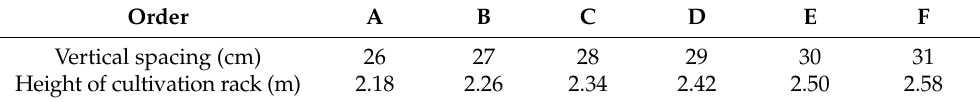
Table 4. Parameters of cultivation racks in the vertical spacing